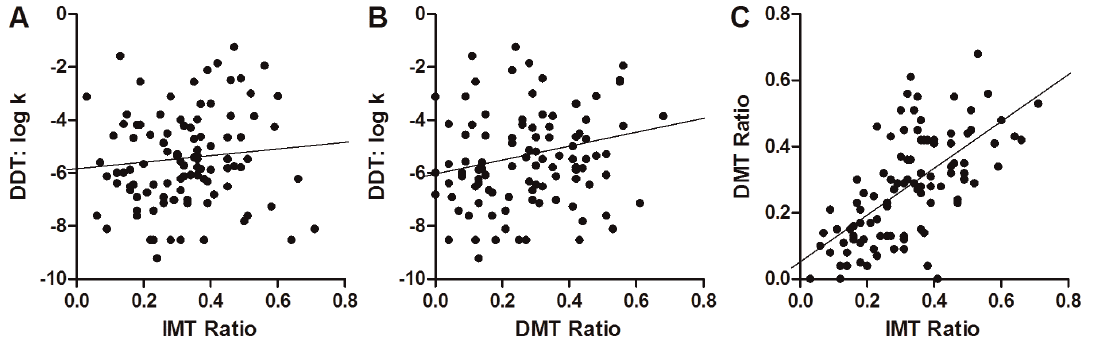
Figure 4. Correlation between impulsive choice and action in humans. In humans (n=100), there was no correlation between impulsive choice (log DDT k value) and impulsive action measured as the ratio of commission errors to correct detections in (A) IMT (r=.11) and (B) DMT (r=.16). Within the IMT/DMT (C) there was a correlation between the ratio of commission errors to correct detections in the IMT and DMT (r=.64).